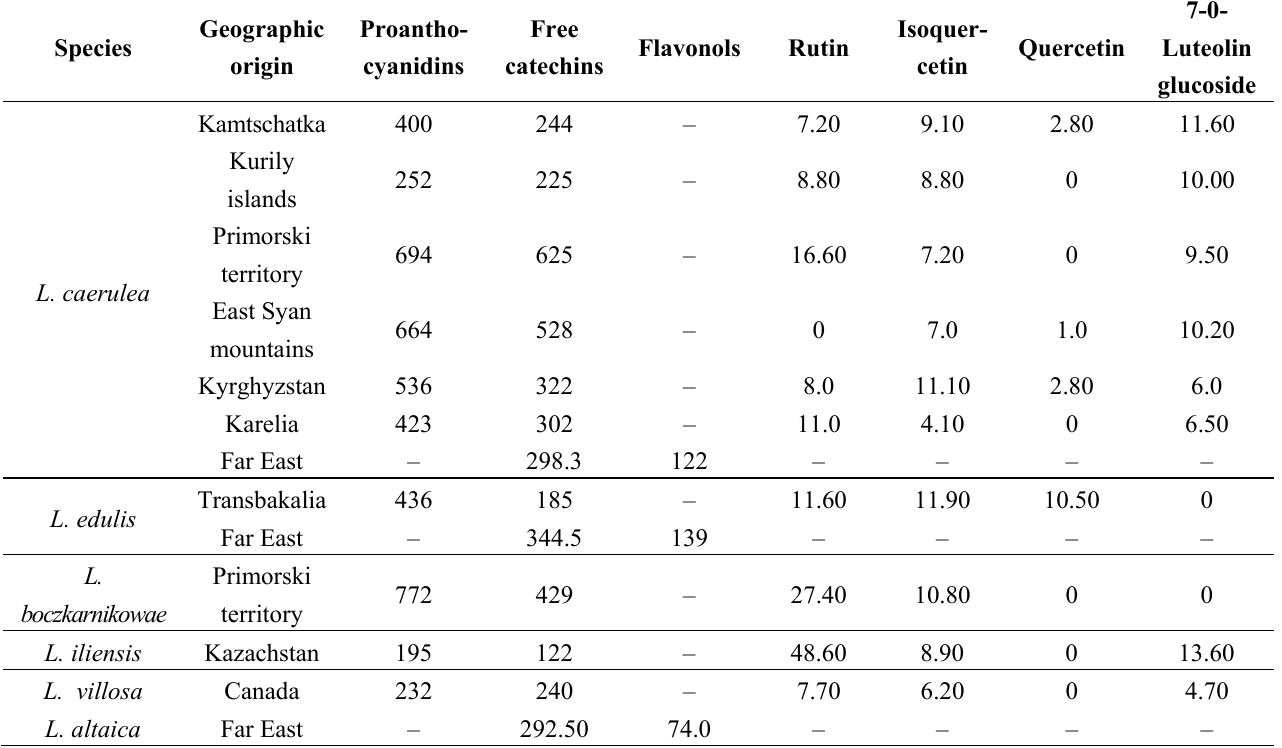
Table 2. Content of flavonoids—flavanes, flavonols and flavones in berries of different Lonicera species (mg/100